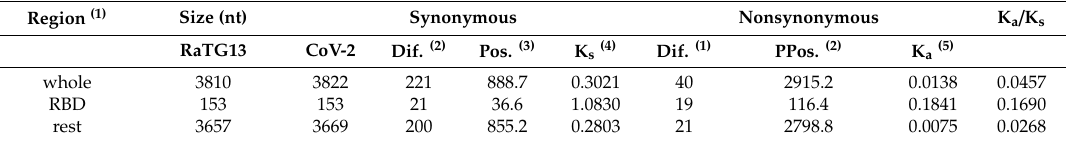
Analysis of nucleotide diversity of the RaTG13 and SARS-CoV-2 coronavirus envelope